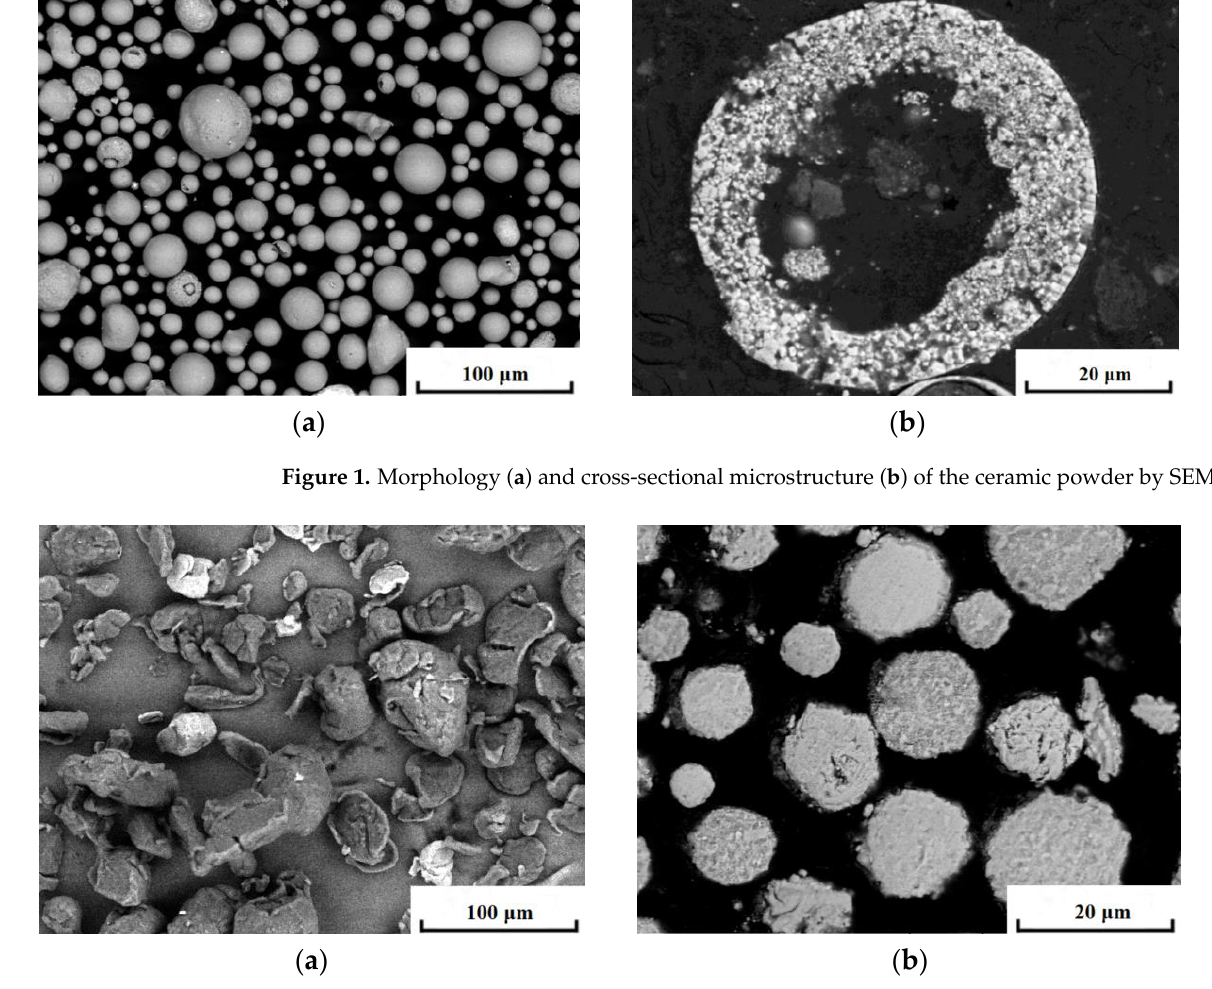
Figure 2. Morphology ( a ) and cross-sectional microstructure ( b ) of the polypropylene powder by SEM.